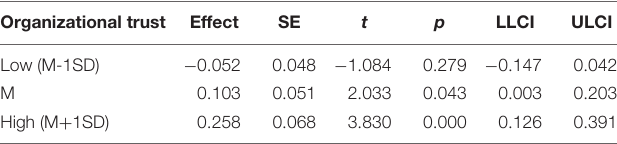
TABLE 5 | Conditional effects of perceived environmental corporate social responsibility (ECSR) on organizational identification at values of organizational trust.